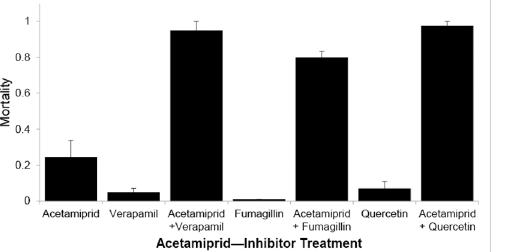
Fig 3. Increased sensitivity of honey bees to the neonicotinoid insecticide acetamiprid. Mean mortality ( ± SE) of honey bees fed 0.1 μ g/ μ l acetamiprid with 1 mM solutions of inhibitors in sucrose syrup. All inhibitor- acetamiprid combinations had significantly greater 24 h mortality than the acetamiprid-only control (P < 0.0002).